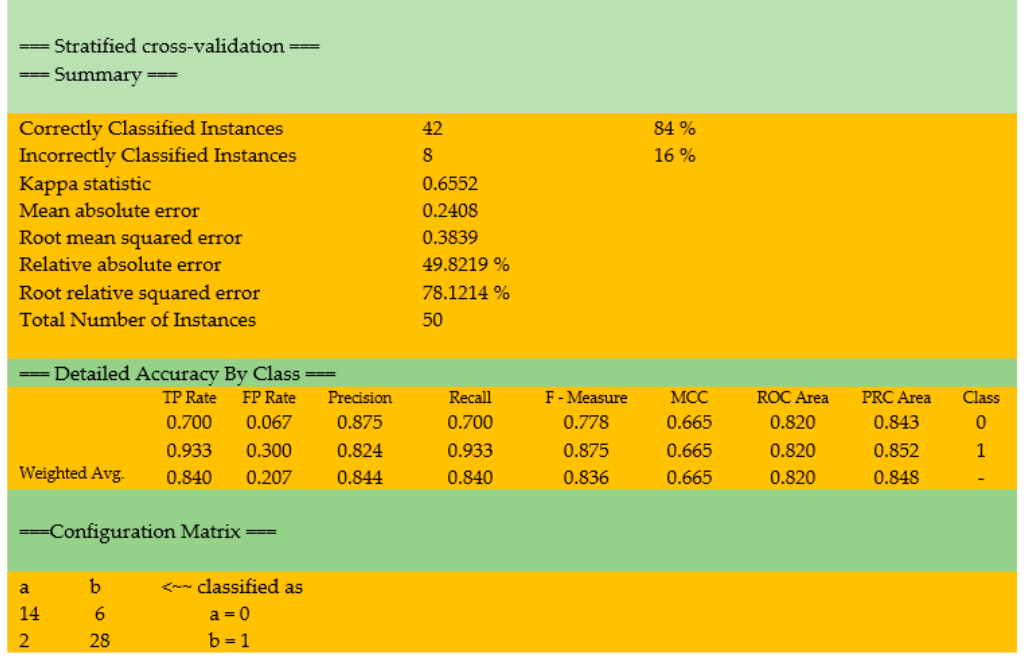
Figure 4. Output of the WEKA software using the multilayer perceptron (MLP) algorithm.